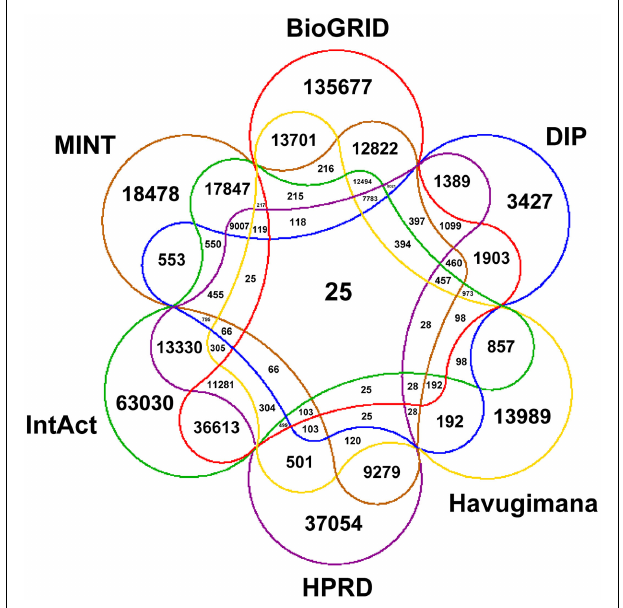
FIGURE 1 | Venn diagram showing the number of common interactions across PPI datasets in SPECTRA .